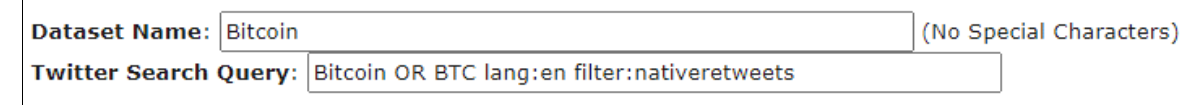
Figure 2(a). Twitter search query for Bitcoin in